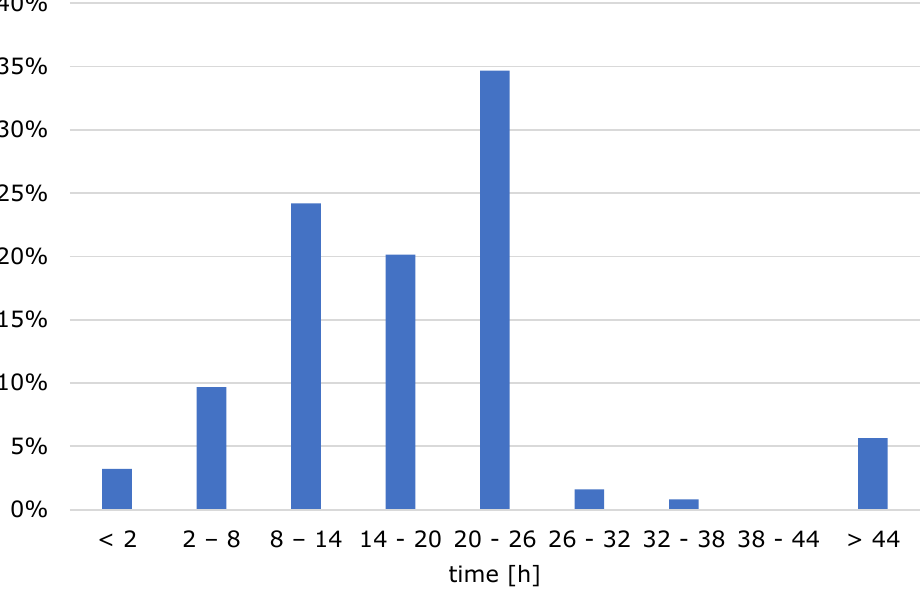
brew for 14 to 26 h. The median extraction time is 16 h. Some also extract between 8 and 14 h, but few of the respondents extract for less than 8 h and even fewer extract for more than 26 h. In addition, it is notable that there is a small proportion who extract for more than 44 h.